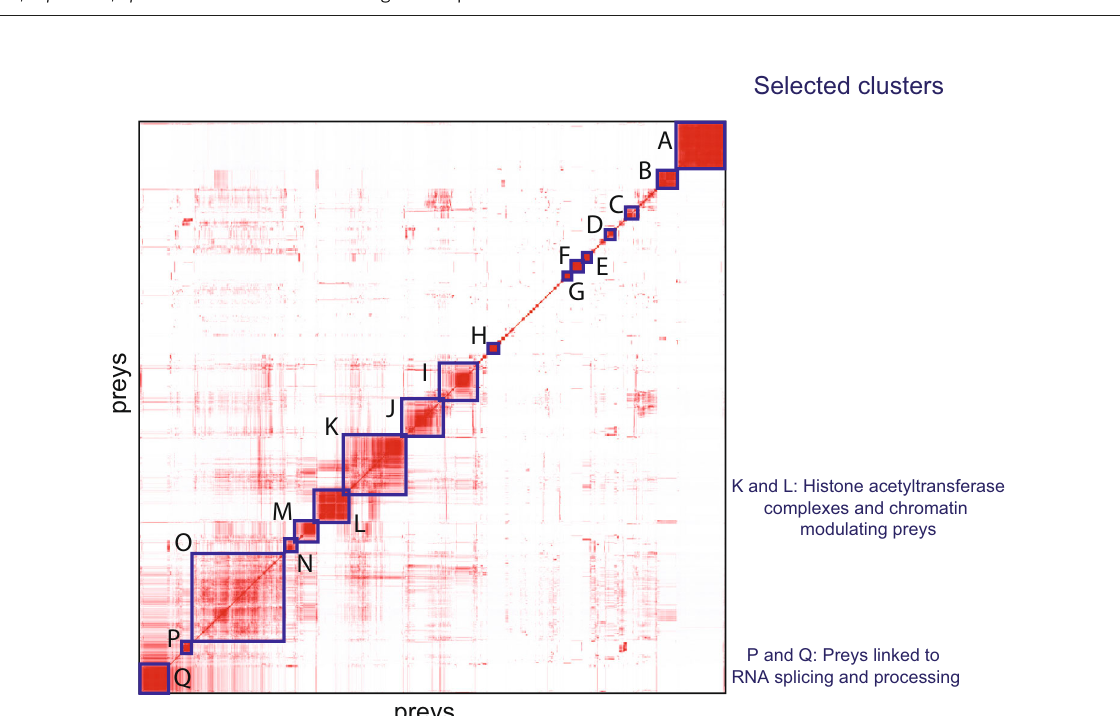
Fig. 4 TF-TF (bait-bait) interactions of 109 TFs studied. a Of 109 studied TFs, 80 had 202 interactions with other studied TFs. Blue edges indicate interactions from the BioID analysis, red from the AP-MS analysis and green from both. b Most of these TF-TF (118) interactions were TF interactions with NFIs (left panel). The right panel shows the separate groups shared by one or multiple NFIs. Color code: Green nodes = NFIs, yellow nodes = interactions to NFIs, orange nodes = interactions from NFIs, red nodes = interactions to and from NFIs and gray nodes = no interactions to or from NFIs. Color coding of the nodes is shown on the right side of the fi gure. The edge weight displays the average spectral count value detected for the corresponding interaction.